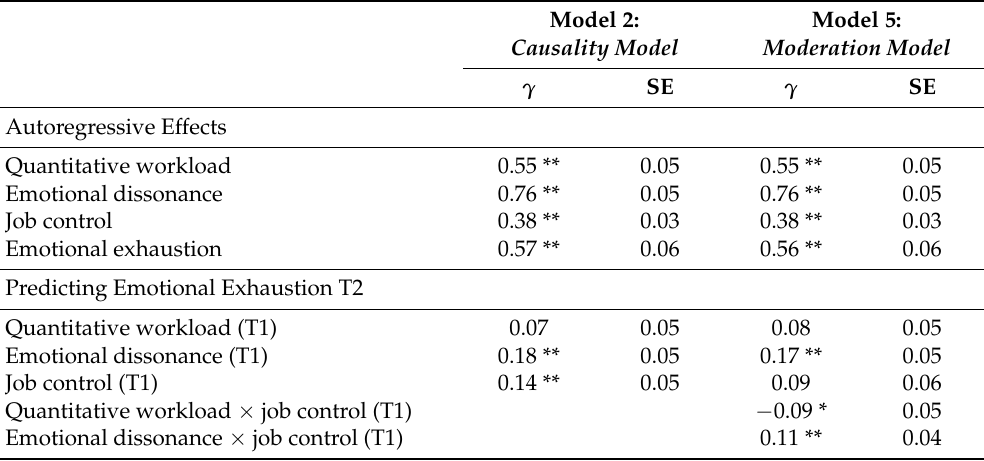
Table 3. Parameter estimates of path